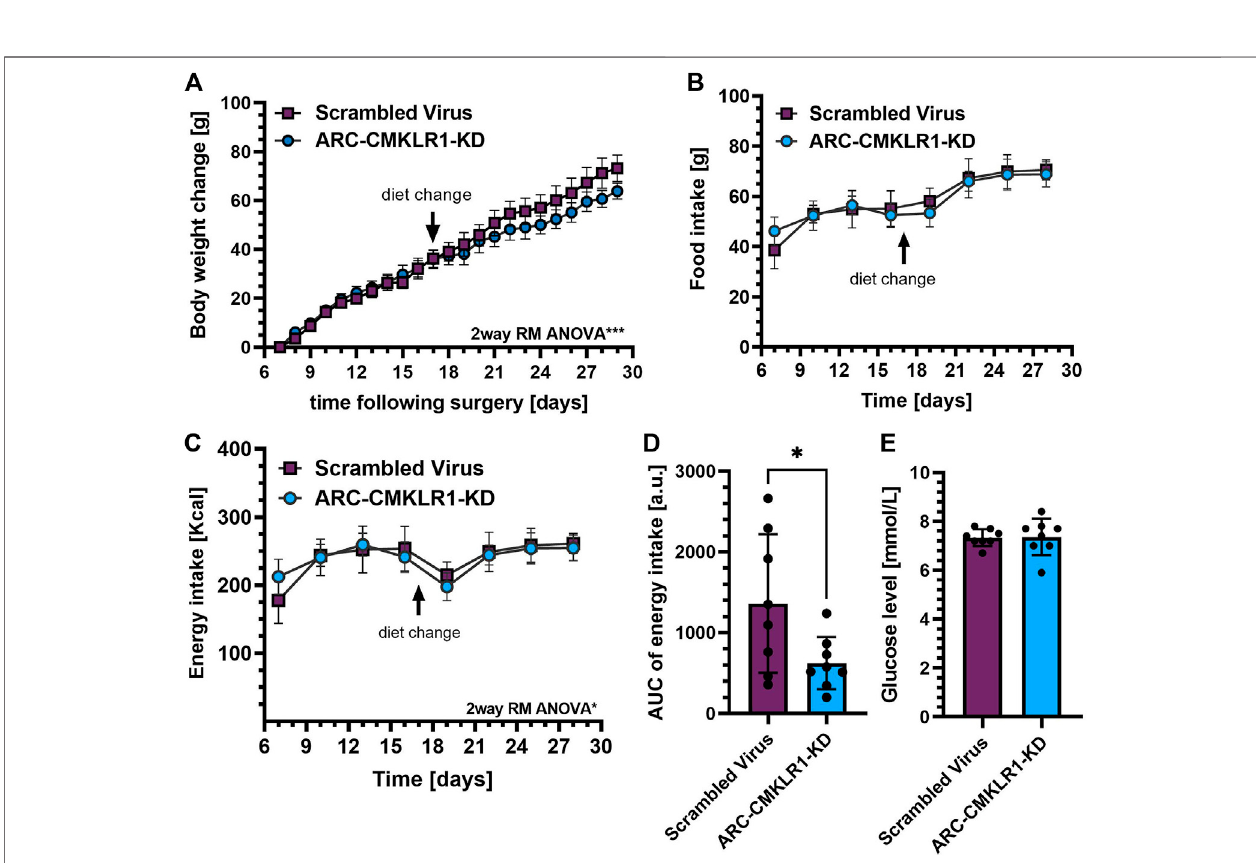
FIGURE3| Effect CMKLR1 knockdown inthearcuate nucleus onbodyweight,glucoselevels, foodand energyintake. AdultSprague Dawleyratsonhigh-fatdiet receivedabilateralinjectionofashRNAconstructtargetedagainstCMKLR1oracontrolconstruct( n =8/group).Aftersurgery,theratsweremaintainedonahigh-fatdiet for 17 days and then switched to chow diet. (A) Body weight change was calculated as the difference between body weights measured after post-operative recovery (day 7 after surgery) and 29 days after surgery showing that weight gain was inhibited in ARC-CMKLR1-KD rats (time x treatment, p = 0.001). (B) Food intake in 72 h showed no difference but (C) 2way RM ANOVA revealed a signi fi cant difference in energy intake (time x treatment, p = 0.0125) and (D) this was con fi rmed by analyzing the area under the energy intake curve. (E) No signi fi cant difference was found in unfasted glucose levels 29 days following surgery. Data are presented as mean ±